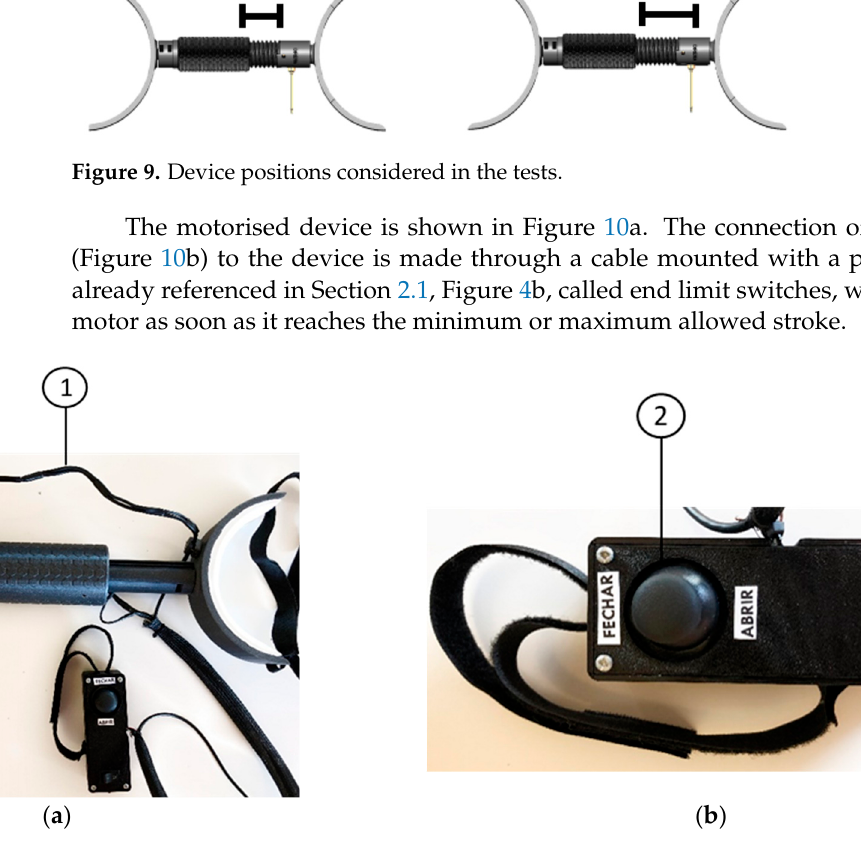
Figure 10. ( a ) Motorised device: (1) Camera with adjustable cable; ( b ) Detail of the command unit: (2) Button on/off; (3) Joystick.